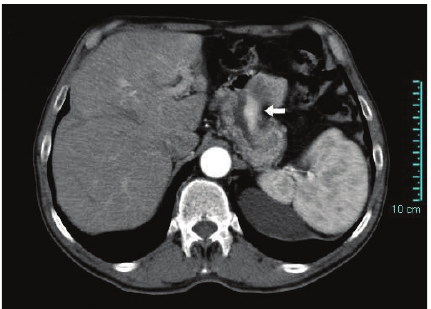
Figure 1: Computer tomography with intravenous contrast of the abdomen showing a thickening of gastric stump (white